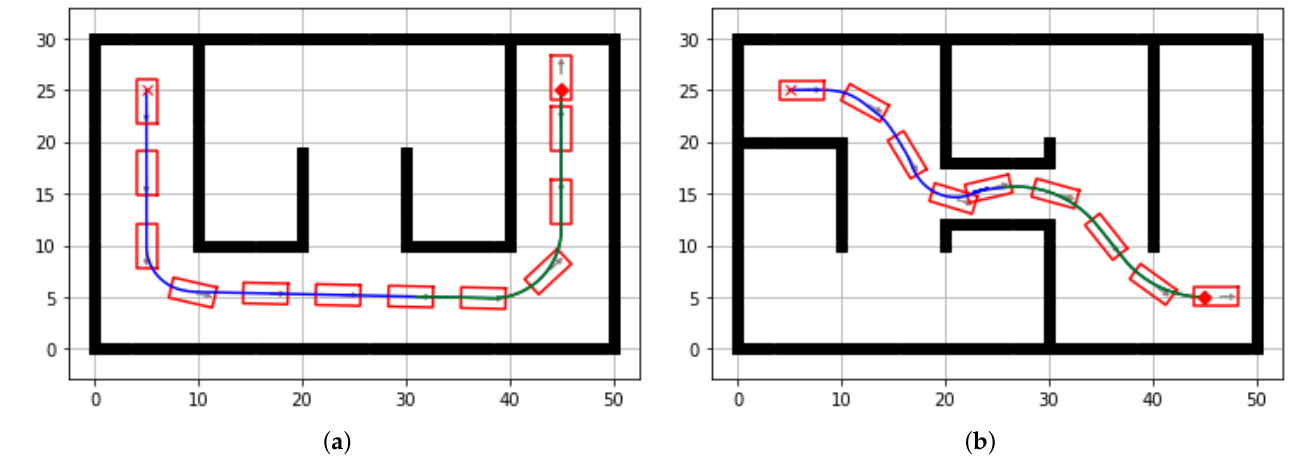
Figure 7. Tuning the improved hybrid A-star path planning. ( a ) Grid map A. ( b ) Gird map B.